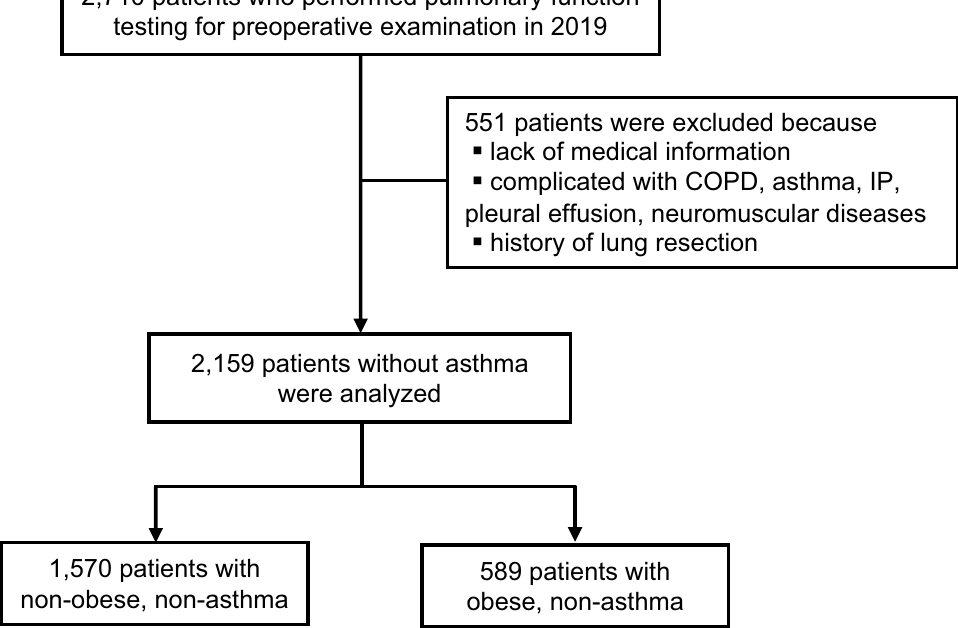
Figure 2. Study design: Patients without asthma. A total of 2159 patients without asthma were extracted, and 1570 non-obese patients without asthma and 589 obese patients without asthma were analyzed.